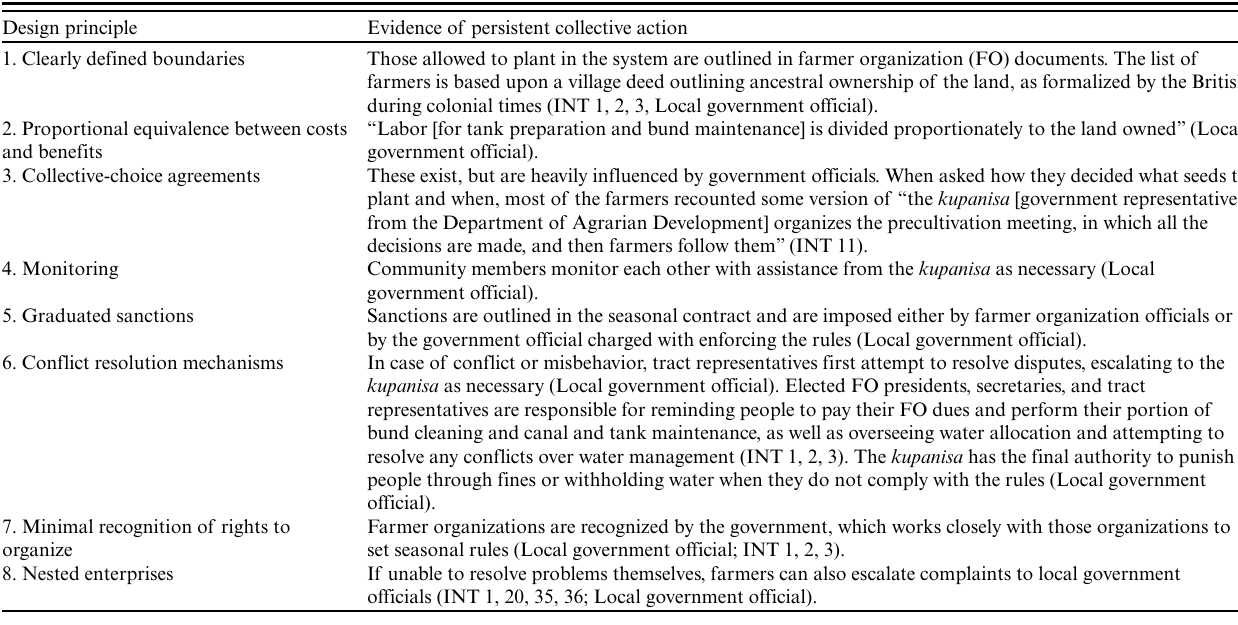
Table 2 . Ostrom’s (1990, 1993) design principles in today’s minor